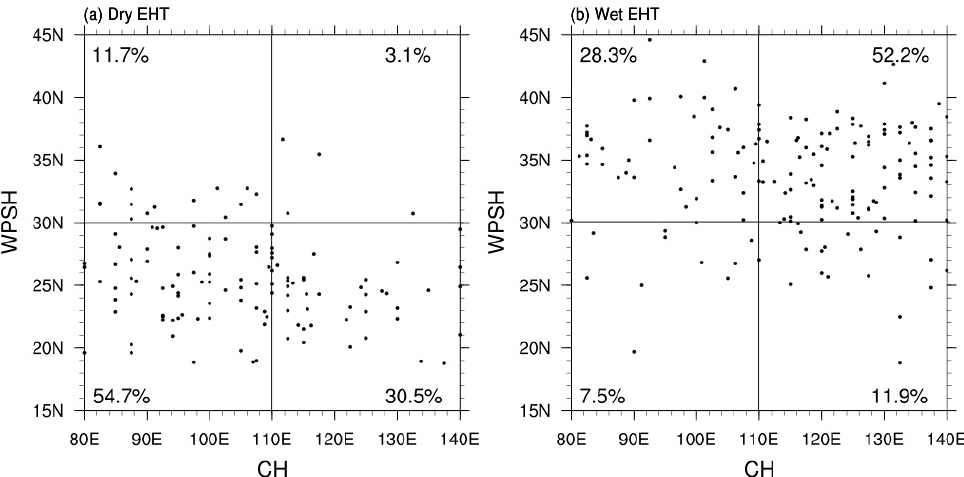
Figure 6. Scatter diagram of the zonal location of CH and the latitude location of the WPSH for ( a ) dry and ( b ) wet EHT days. The percentage in each quadrant is the proportion of EHT days in this quadrant to EHT days in these four quadrants.